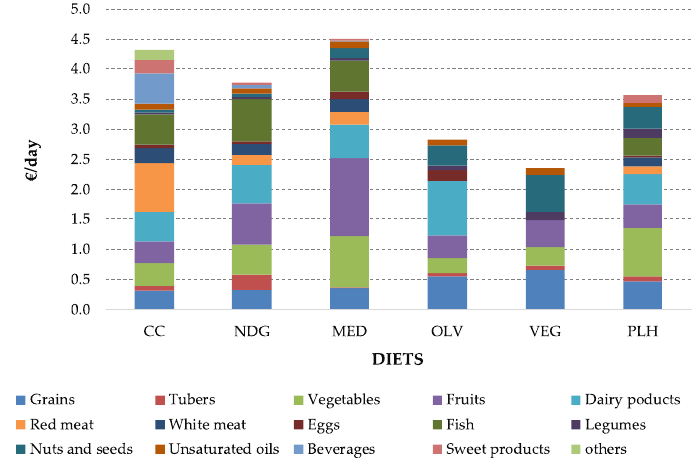
Figure 2. Cost (€/day) of all pre-defined diets. Figure 2. Cost ( € / day) of all pre-defined diets.